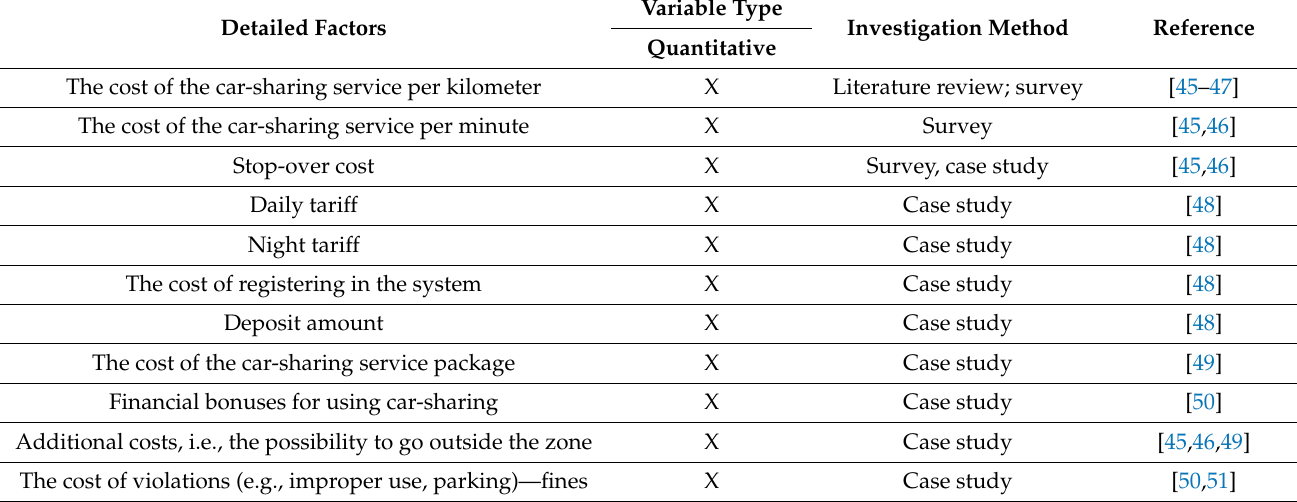
Table 1. Costs of